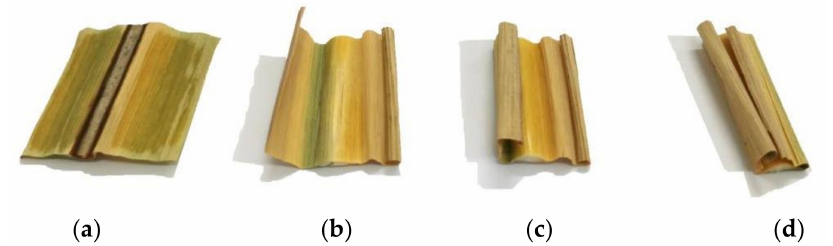
Figure 3. Sugarcane leaf samples with different deformation: ( a ) flat leaf, ( b ) slightly deformed leaf, ( c ) moderately deformed leaf, ( d ) seriously deformed leaf.